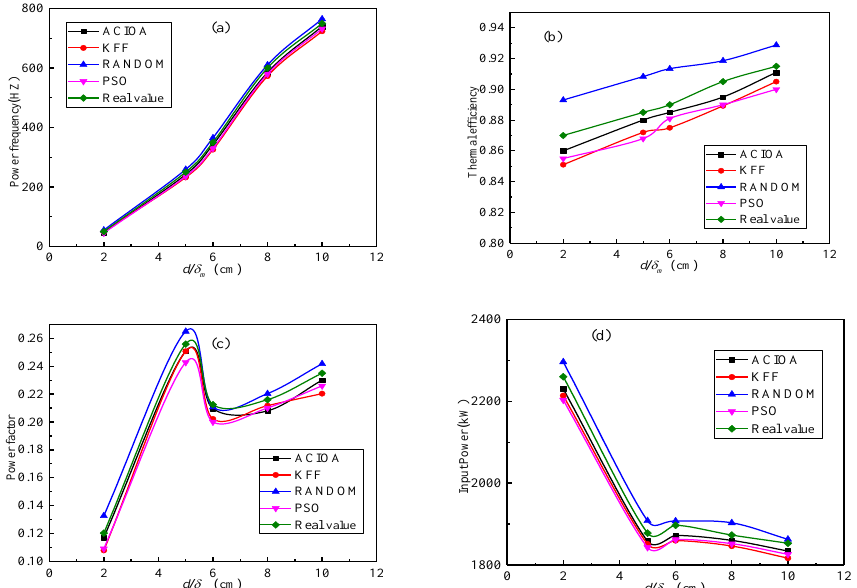
Figure 8. Effect of ratio of charge diameter to current penetration depth on circuit performance parameters. ( a ) power frequency; ( b ) thermal efficiency; ( c ) power factor; ( d ) input power.